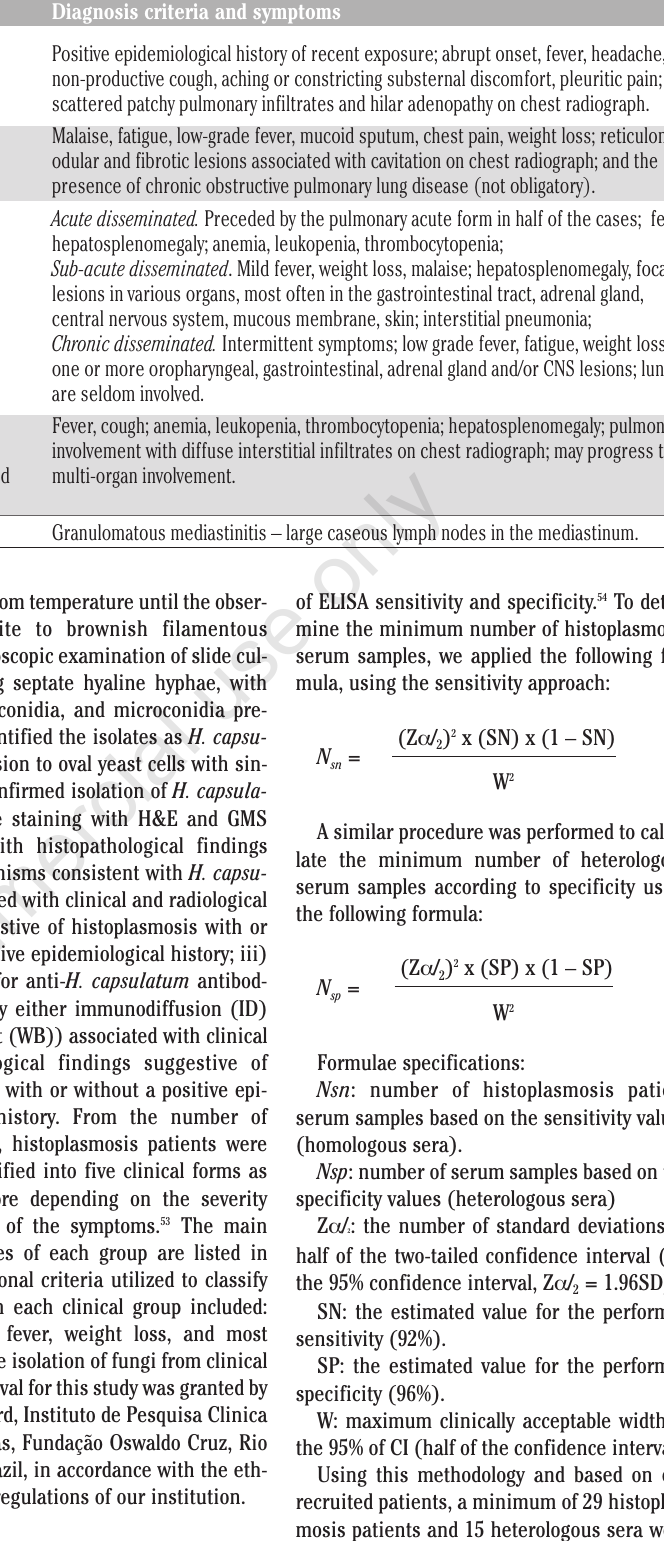
Table 1. Classification of patients with histoplasmosis according to clinical-manifestation and diagnosis criteria. Clinical forms Diagnosis criteria and symptoms